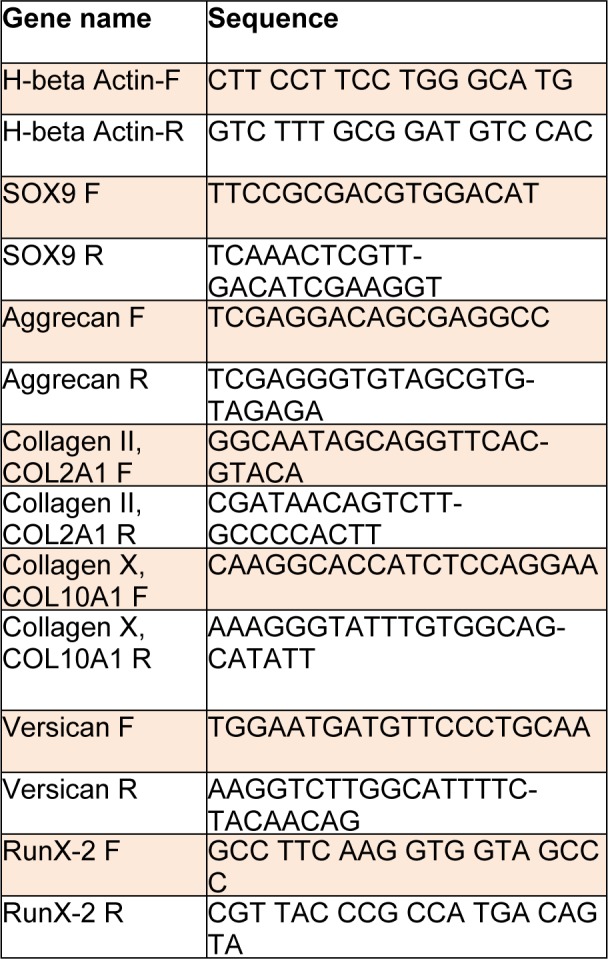
Primer sequences